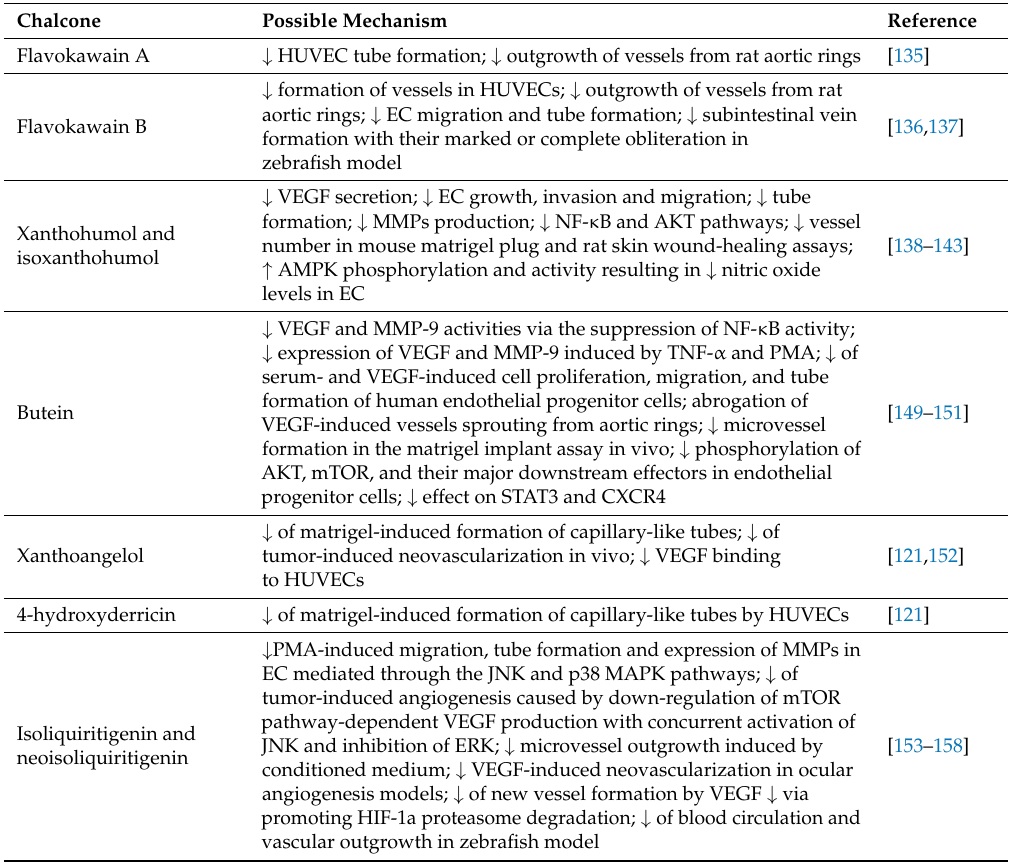
Table 3. Antiangiogenic effect of selected natural